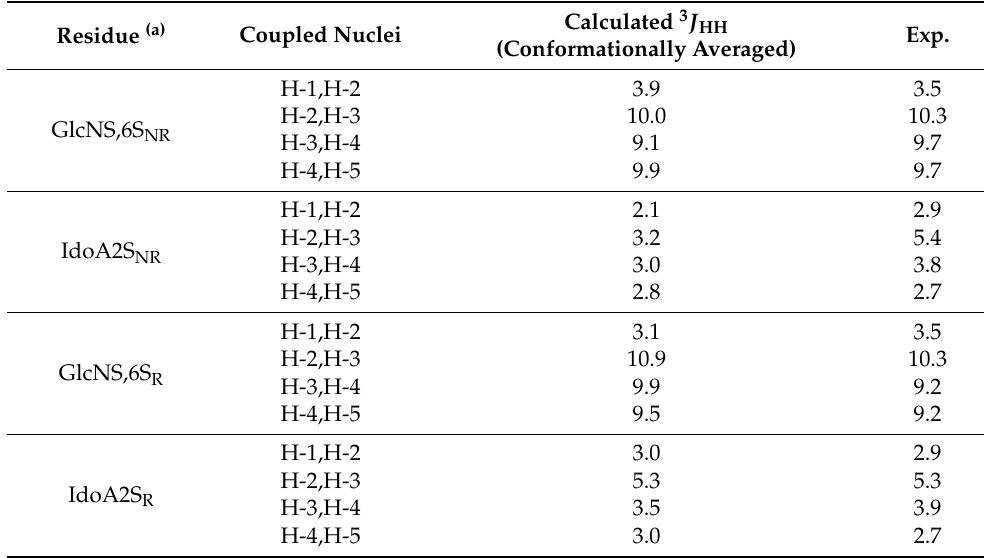
Table 4. Computed averaged vicinal proton-proton coupling constants (Hz) of heparin tetrasaccha- ride as compared to experiment. Compiled from Hricovini